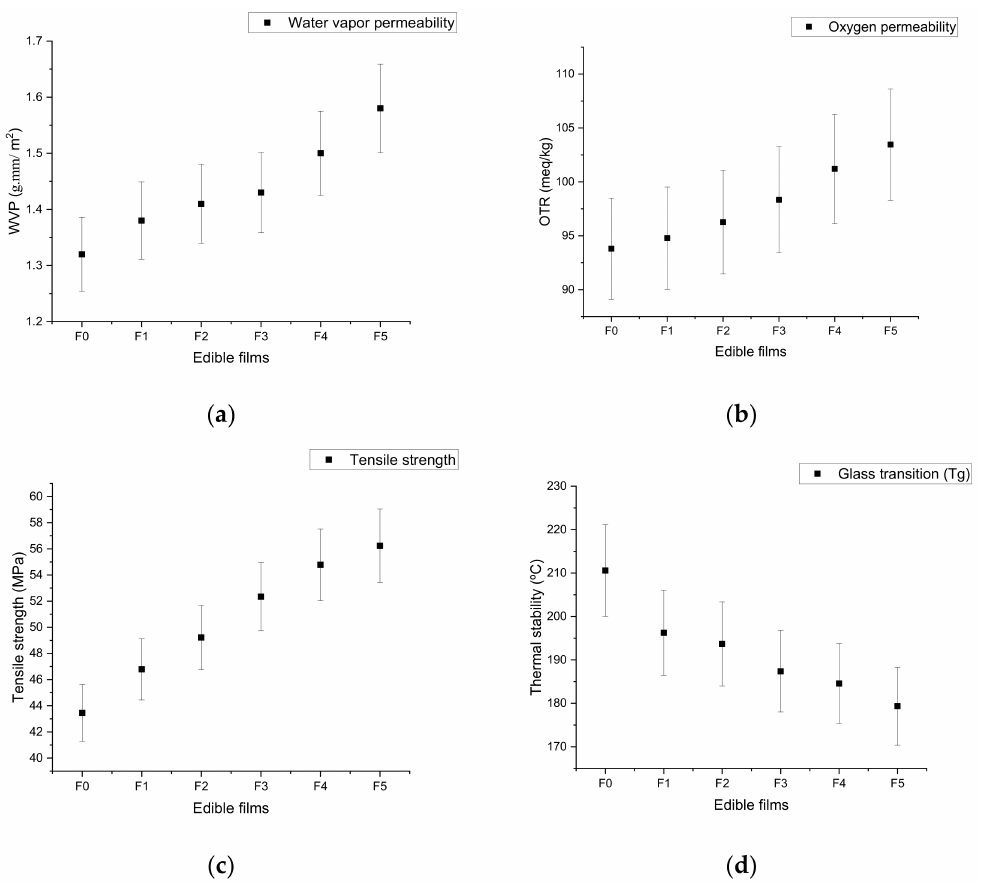
Figure 5. Effect of pomegranate peel extract on water vapor permeability ( a ), oxygen permeabil- ity ( b ), tensile strength ( c ), and thermal stability ( d ) of chitosan-based edible films. F0 = control (chitosan), F1 = 0.2 g/mL PGP, F2 = 0.4 g/mL PGP, F3 = 0.6 g/mL PGP, F4 = 0.8 g/mL PGP, and F5 = 0.10 g/mL